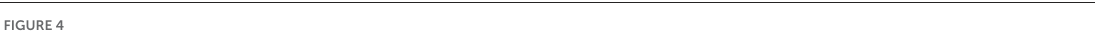
FIGURE4 toddlers’ responses to supplementary gestures in dining activities. Toddler responses include toddler responses into the following: gesture-related attentional disengaging (GAD), gesture-related gestures (GGs), gesture-related actions (GAs), gesture-related language (GL), gesture-related integrative responses (GIs) and non-GAD, non-GGs, non-GAs (NGAs), non-GL (NGL), and non-GIs, with error bars showing ± standard error. # Adjusted p < 0.005.